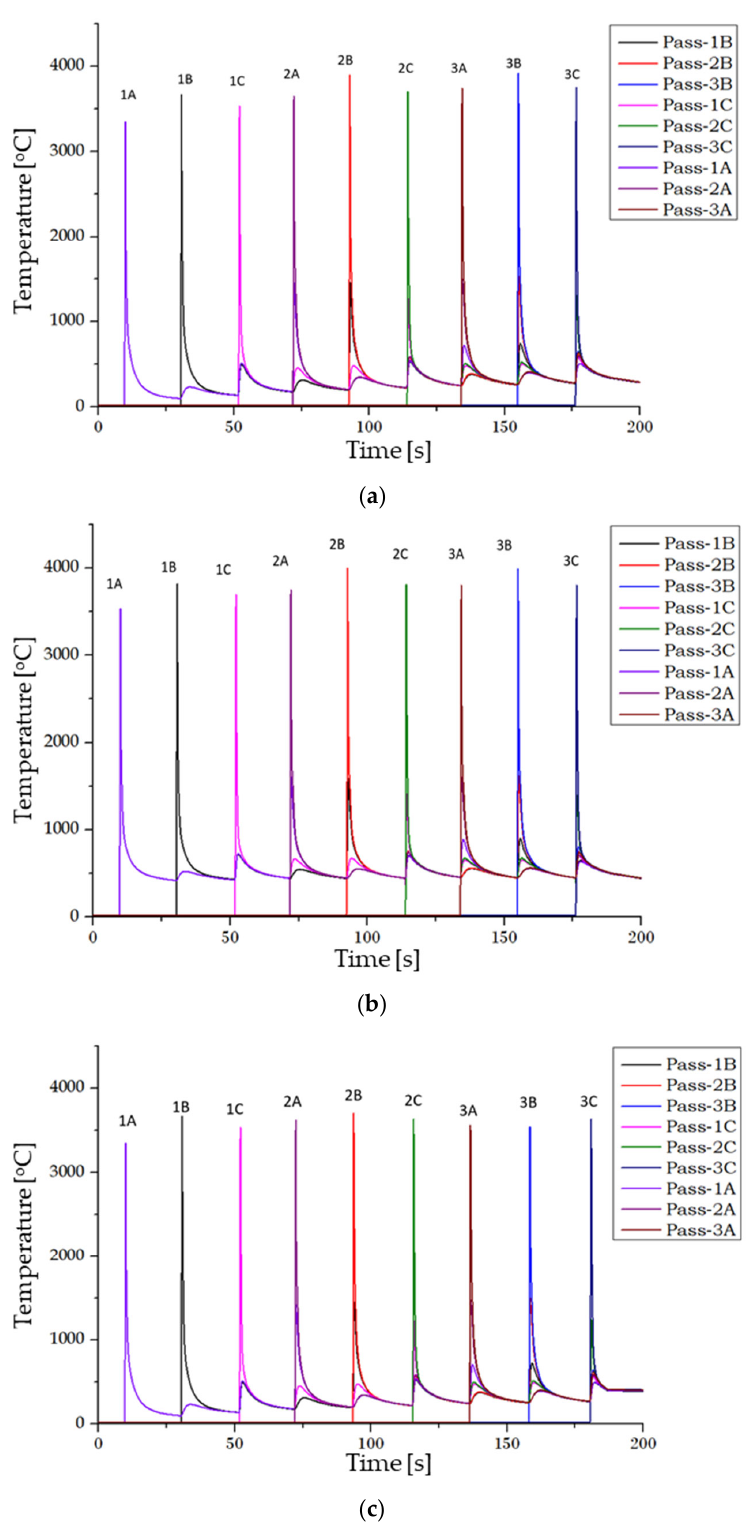
Figure 15. Temperature vs. time plot of weld passes A–C for ( a ) A, Insulated plate, ( b ) B, Insulated + heated substrate (400 °C); ( c ) C, Insulate base + adaptive current.